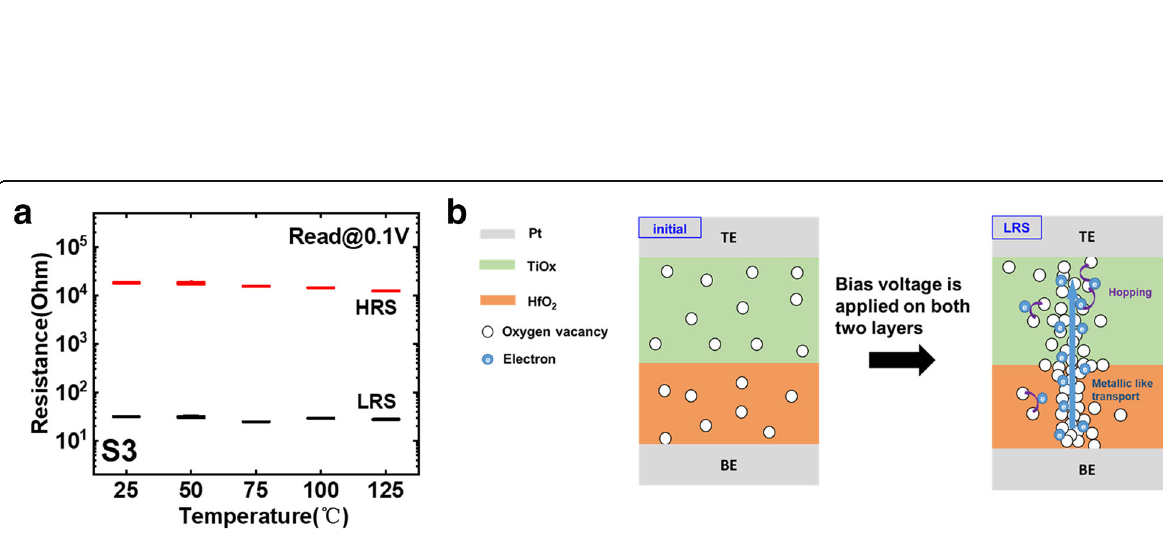
Fig. 10 a The resistance changes with temperature in S3. b The corresponding schematic diagram of conductive